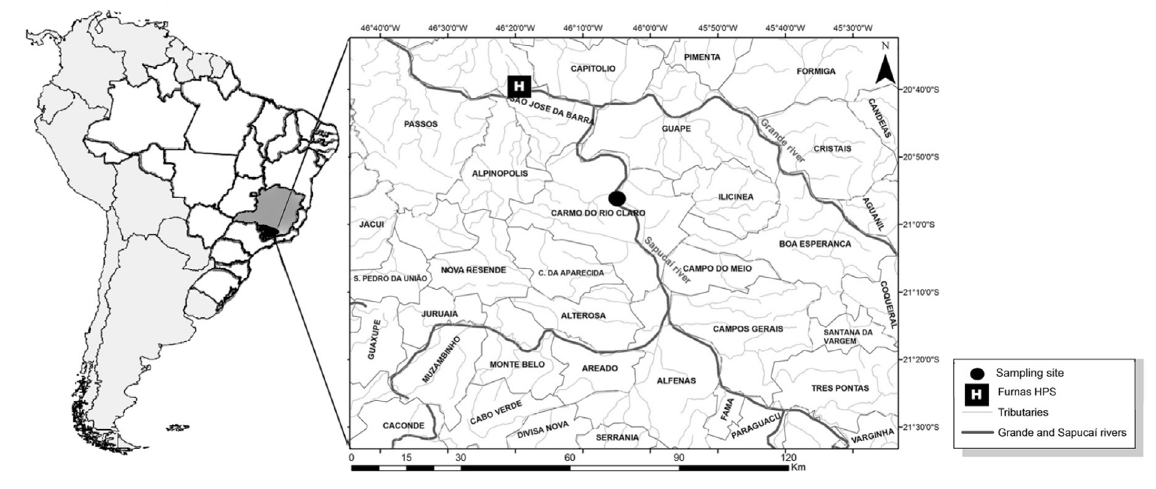
Figure 1. Map showing sampling site location at Furnas HPS reservoir (state of Minas Gerais, southeastern